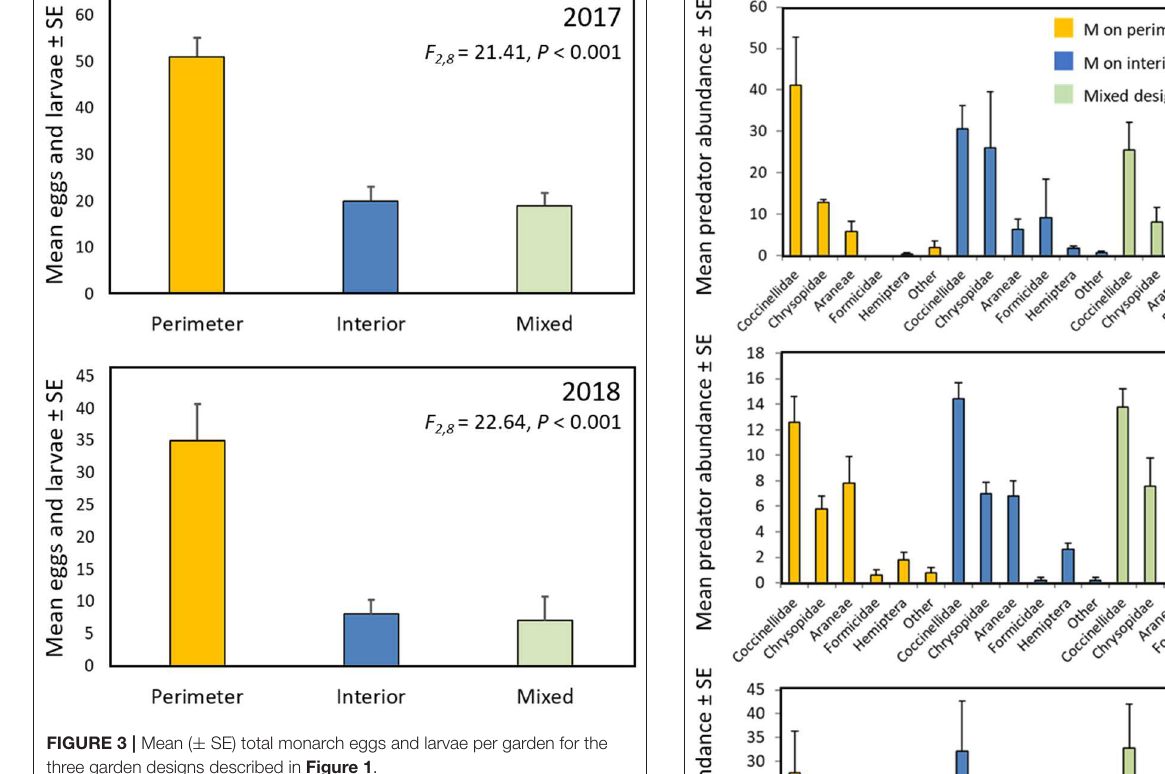
Stenoien et al., 2015; Baker and Potter, 2018; Geest et al., 2019).